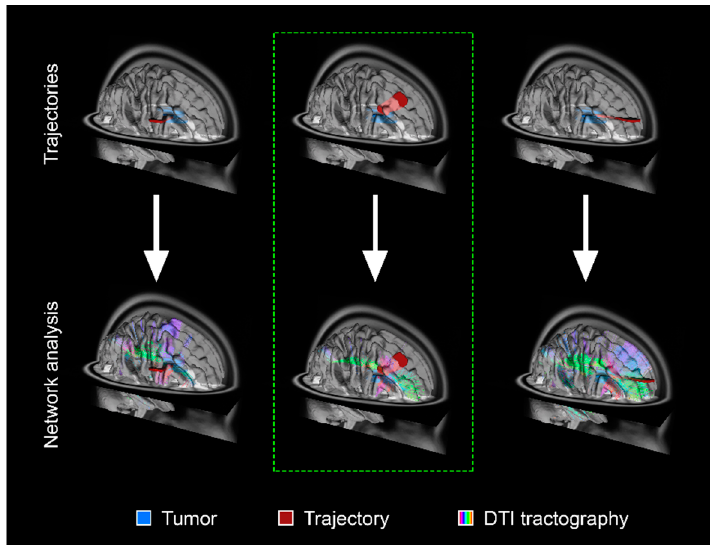
Figure 2. Schematic of pre-operative structural connectivity to identify optimal trajectories for tumor resection and minimal network disruption. The top panels demonstrate a representative schematic of an intra-axial tumor (blue) and possible surgical trajectories (red). The bottom panels show the corresponding network analysis based on DTI tractography. The trajectory demarcated by the dashed green line represents the surgical trajectory with minimal structural network disruption. A similar approach can be applied to visual representations of functional networks derived from other modalities to infer connectivity.